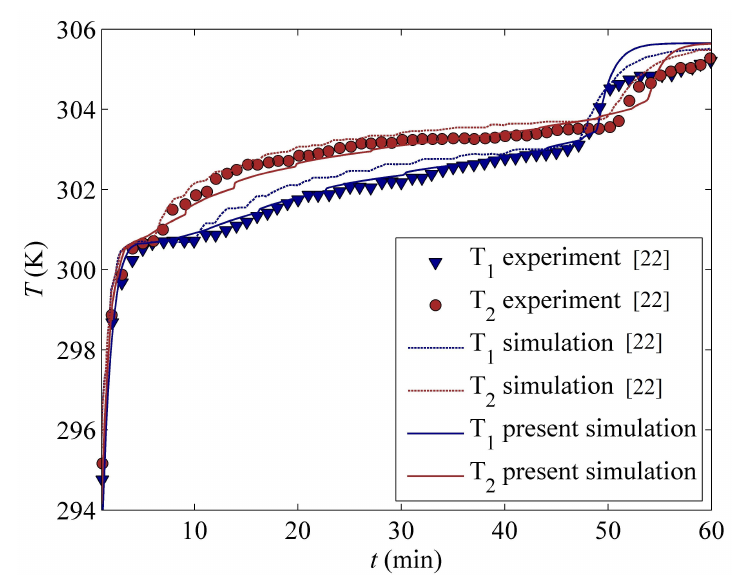
Figure 2. Validation of numerical model with experiments [15].